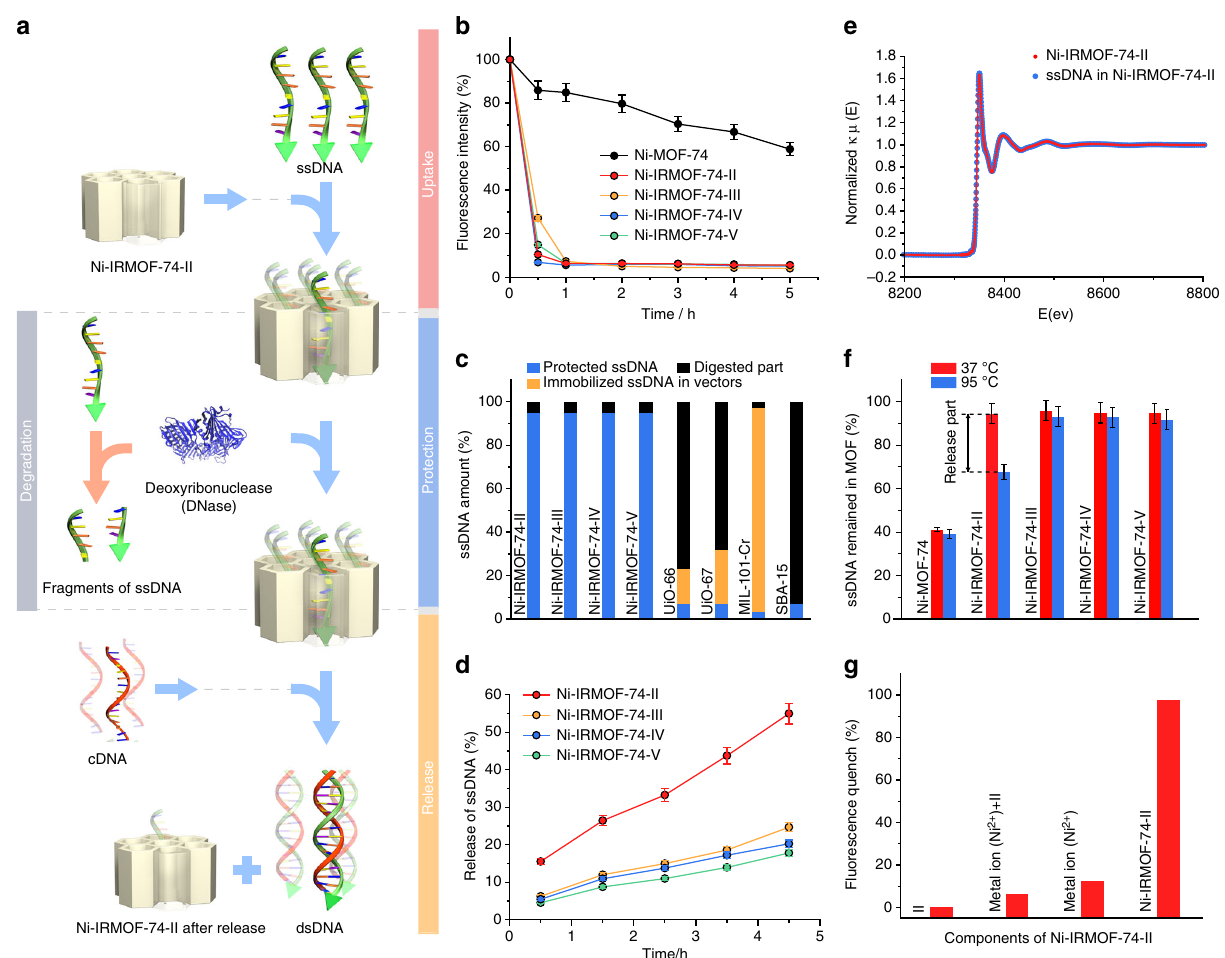
Fig. 3 Uptake, protection, and release of ssDNA using MOFs as vectors. a Illustration of three critical processes in ssDNA transfection. b Uptake of ssDNA in Ni-IRMOF-74 samples ( n = 3 technical replicates; bars represent mean ± s.d.). c Protection of ssDNA using various porous materials in FBS with 10% serum. Survived portion, residual left inside the vectors and digested portion of ssDNA are labeled in blue, yellow, and red, respectively. d Release of ssDNA from Ni-IRMOF-74 samples in the presence of cDNA ( n = 3 technical replicates; bars represent mean ± s.d.). e X-ray absorption spectra of Ni- IRMOF-74-II before and after loading with ssDNA, blue and red, respectively. f Experiments that rule out the possibility of H-bond between ssDNA and MOFs. Ni-IRMOF-74 samples loaded with ssDNA were heated at 37 °C and 95 °C, red and blue, respectively ( n = 3 technical replicates; bars represent mean ± s.d.). g Fluorescence quench of FAM-labeled ssDNA in contact with IRMOF-74-II and its